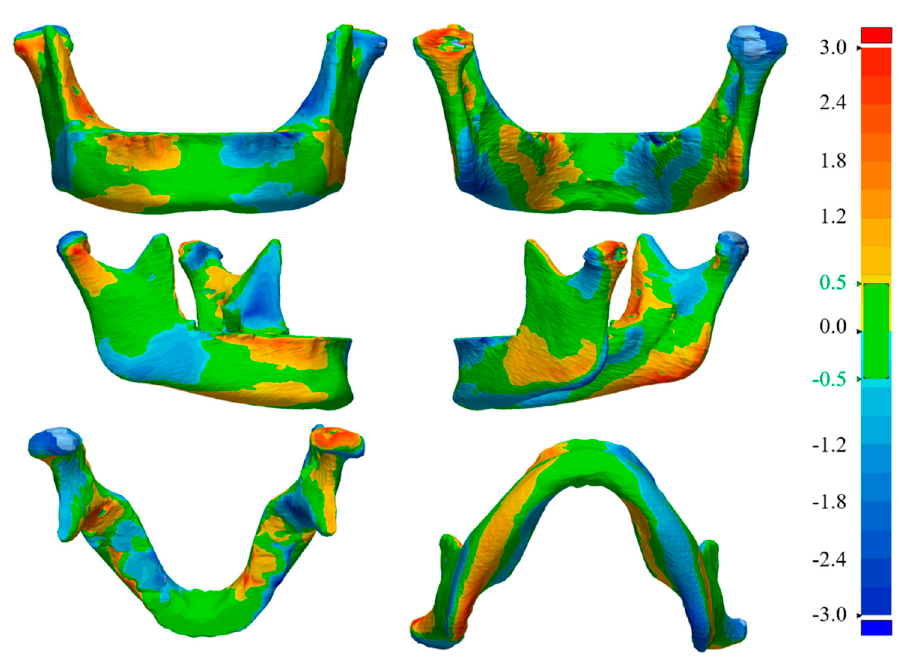
Figure 8. Surface deviation analysis of mandibles. The map showed the difference between the original mandible model and the mirrored mandible model. The tolerance range was set at 0.5 mm. Table 1. Matching percentages of the mandibular functional